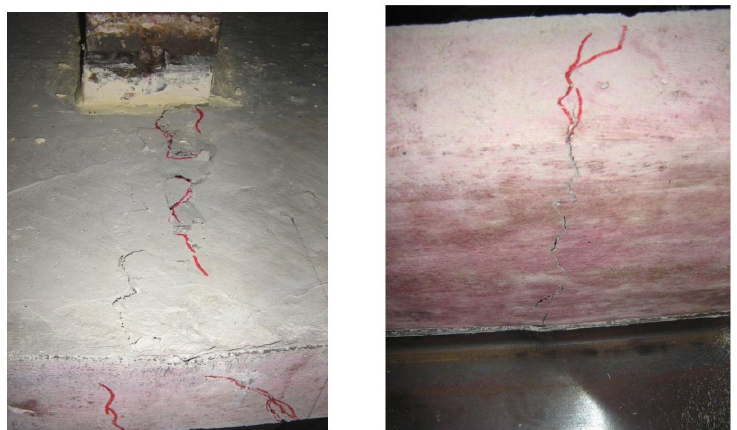
Figure 18. Beam V1A rupture